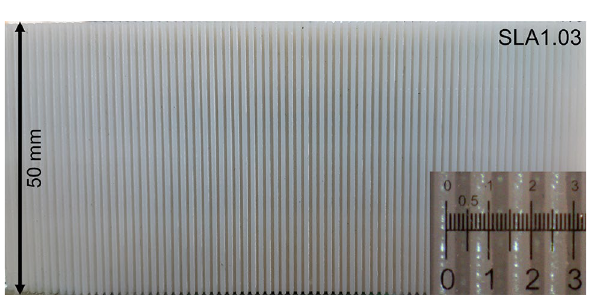
Figure 5. Micro-grooves made by stereolithography (SLA1.03) were used for the capillary rise measurement. The inset shows a micro-groove thickness of 500 µm and a micro-groove width of 400 µm. Micro-groove depth is 1 mm. Table 1 lists the sample